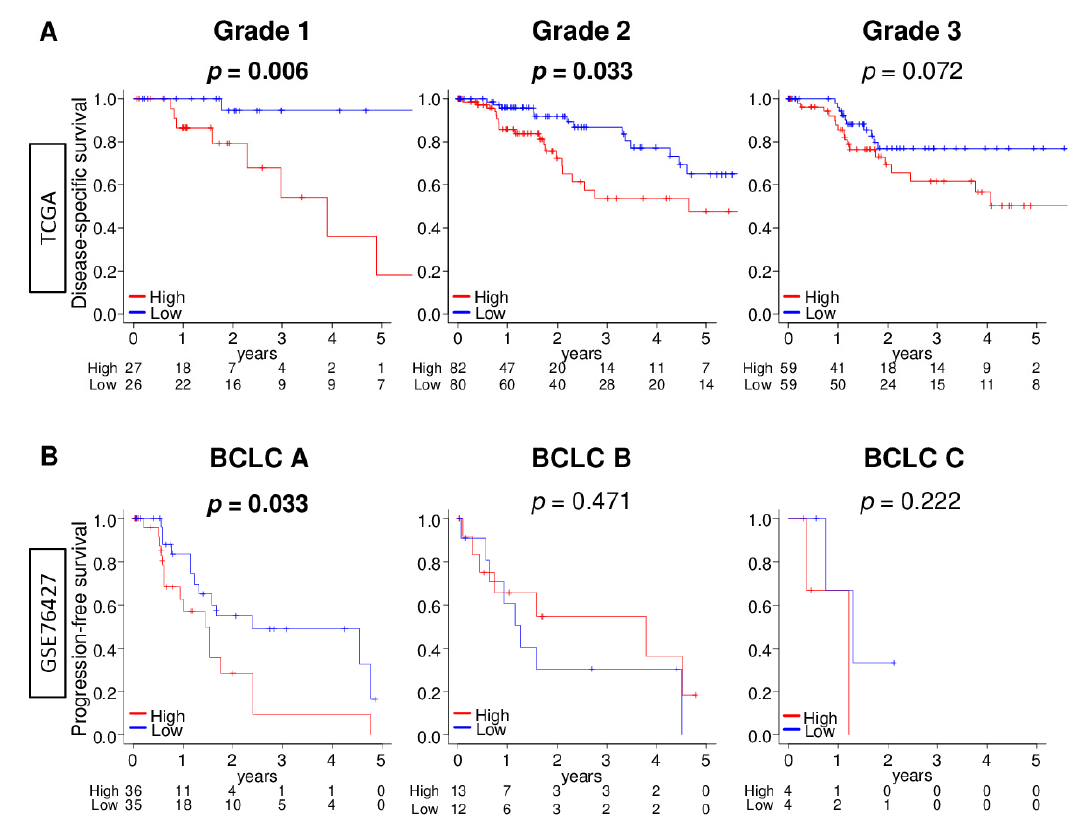
Figure 7. Association of the DNA repair score with patient survival in early and advanced HCC in the TCGA and GSE76427 cohorts. Kaplan–Meier survival curves comparing the low (blue line) and high (red line) DNA repair score tumors for ( A ) disease-specific survival (DSS) in pathological grade 1, grade 2, and grade 3 groups in the TCGA ( n = 358) cohort; and ( B ) progression-free survival (PFS) in the Barcelona Clinic Liver Cancer (BCLC) stage A, B, and C groups in the GSE76427 ( n = 167) cohort. We divided the cohort into low and high DNA repair score groups using the median value as the cut-off. The p -value was calculated using a log rank test. Bold format: significant p values.